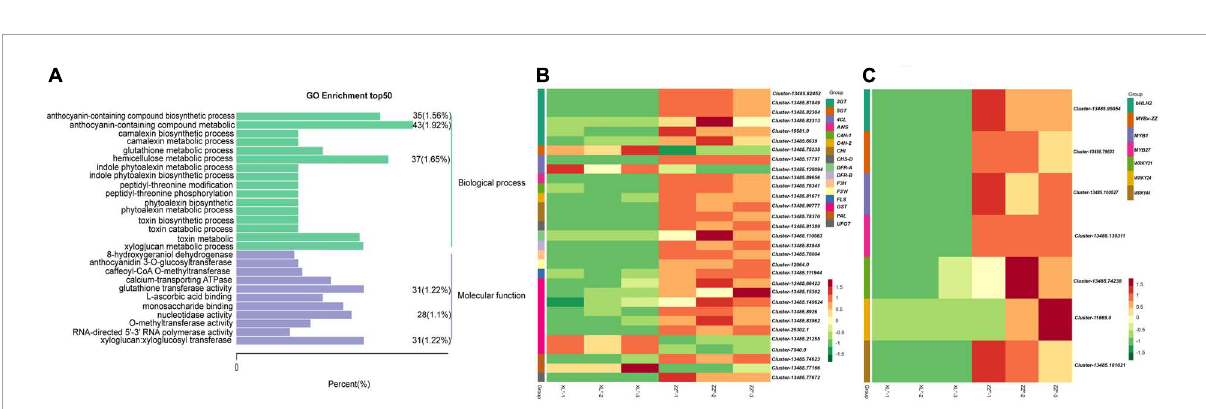
FIGURE2 Differentially expressed genes (DEGs) in tuberous roots of ZZ P and XL Y . (A) Top 50 pathways with the most significant enrichment in GO term between ZZ P and XL Y . The X-axis indicates the number and percentage of DEGs under each functional classification, whereas the Y-axis represents the enriched GO functional classification, which is divided into two categories: biological process and molecular function. (B) Heat map of differentially expressed structural genes relative to anthocyanin biosynthesis pathway between ZZ P and XL Y . (C) Heat map of differentially expressed TFs relative to the anthocyanin biosynthesis pathway between ZZ P and XL Y . Each row represents a gene, and each column represents a sample (XL Y -1, XL Y -2, and XL Y -3 represent three replicates of XL Y sample. ZZ P -1, ZZ P -2, and ZZ P -3 represent three replicates of ZZ P sample). Different colors in the clustering heat map represent the different expression levels of genes. Red and green colors indicate high and low expression levels,